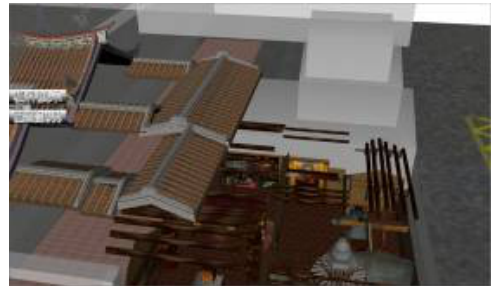
Figure 10. Component dismantling for the Taipei Xia Hai City God Temple